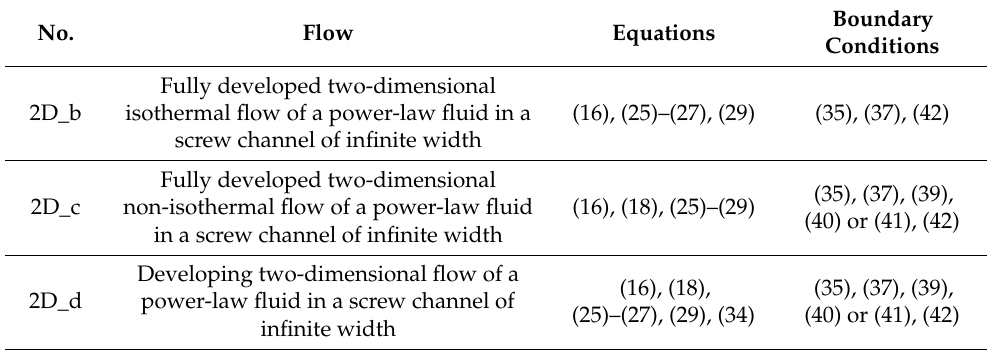
Table 3. Mathematical models of a two-dimensional flow of a power-law fluid in a screw channel of infinite